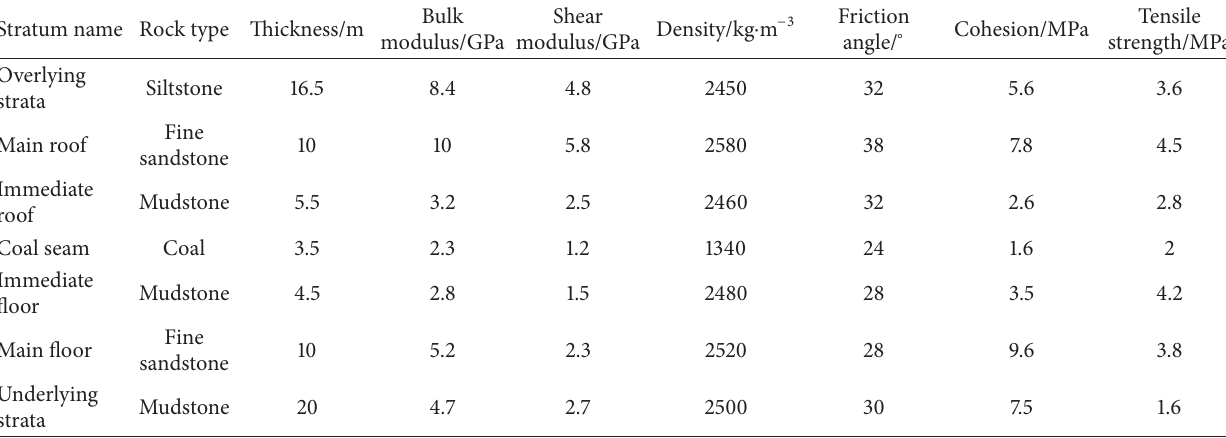
Table 2: Physical and mechanical properties of various